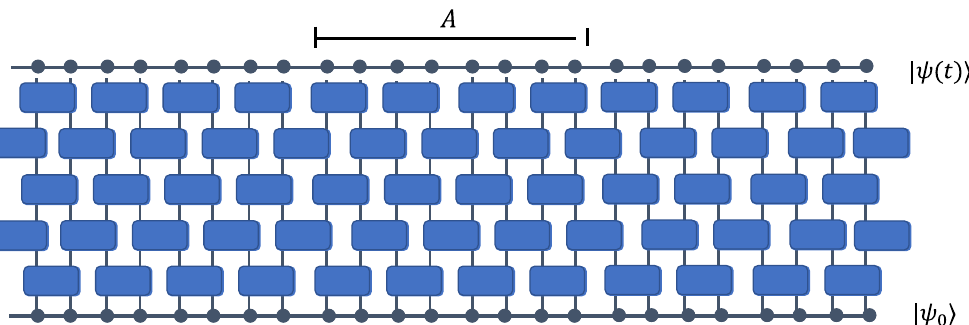
FIG. 16. Time evolution of the initial state | ψ 0 (cid:2) to the state | ψ( t ) (cid:2) = U | ψ 0 (cid:2) at time t by a circuit of local two-site unitary operators in an uncompact system.